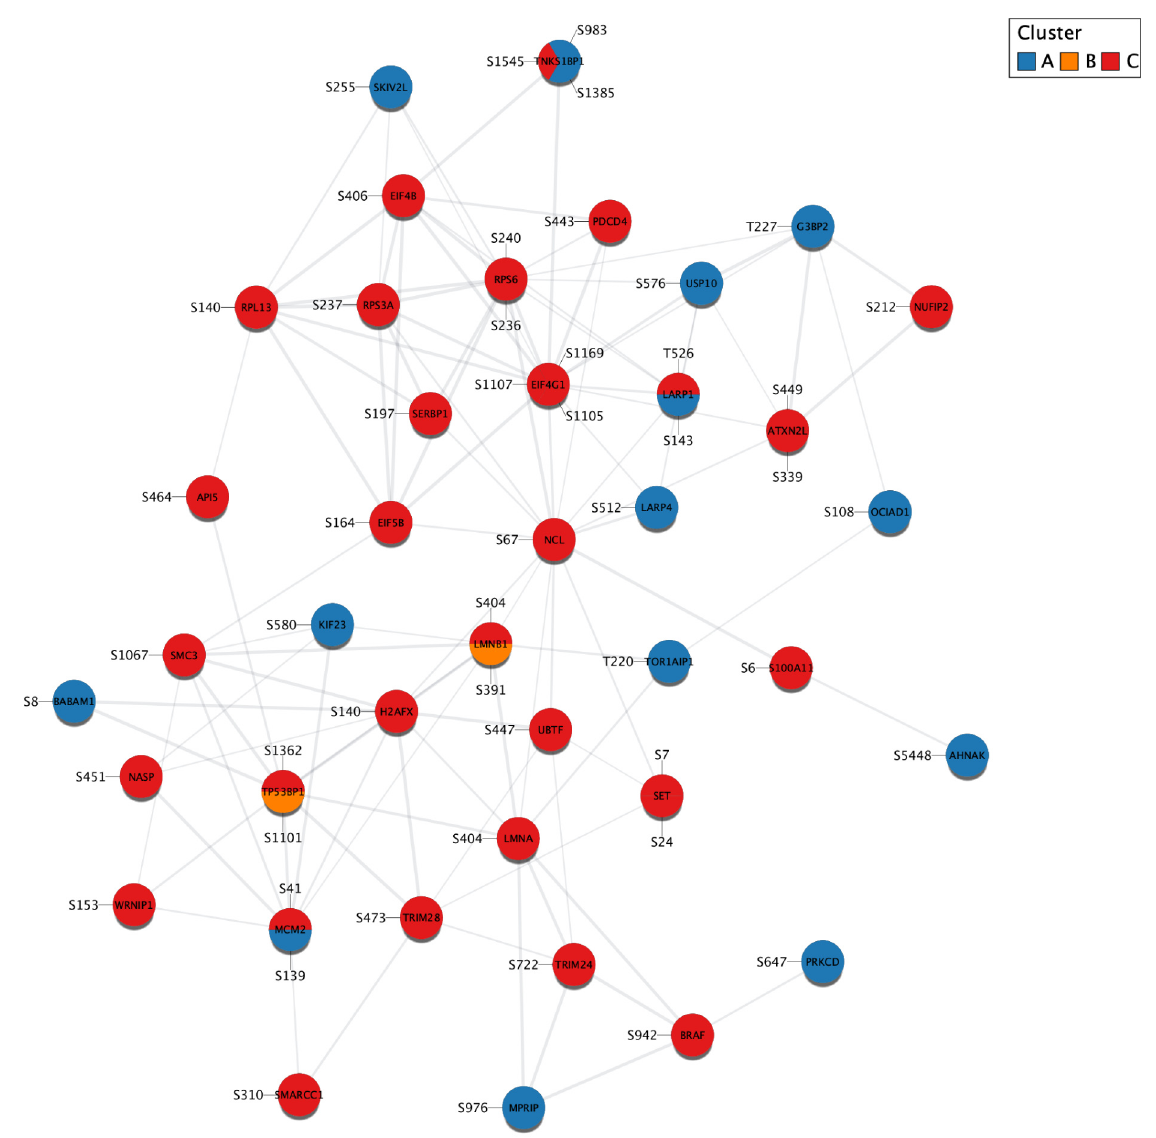
Figure 5. Same network as in Figure 4 with the clusters defined in the original study 10 mapped to the nodes. Each slice of a pie corresponds to a significantly regulated phosphorylation site of the protein and the color of the slice represents the cluster to which the site belongs. Sites abundant in healthy (OSE and FTE), but not cancerous (EOC) tissues are in cluster A; sites abundant in FTE and EOC, but not OSE are in cluster B; and sites abundant only in EOC are in cluster C.